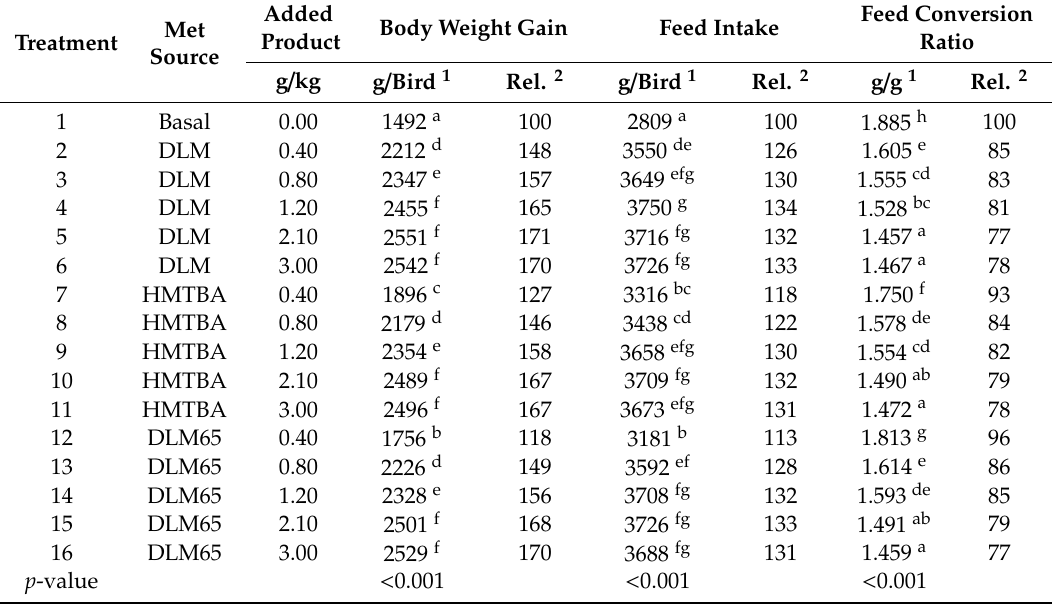
Table 3. E ff ect of increasing levels of Met sources on body weight gain, feed intake, and feed conversion ratio in broilers from 0 to 35 days of